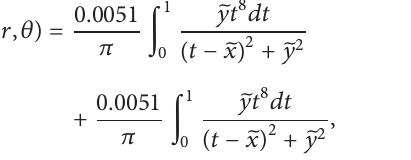
Figure 10: R 󰜚 when 󰜚 = 5 by fixing 𝑛 for ℎ −1 = 32 for different 𝑛 𝐺 𝑆 values of ℎ −1 = 64 .